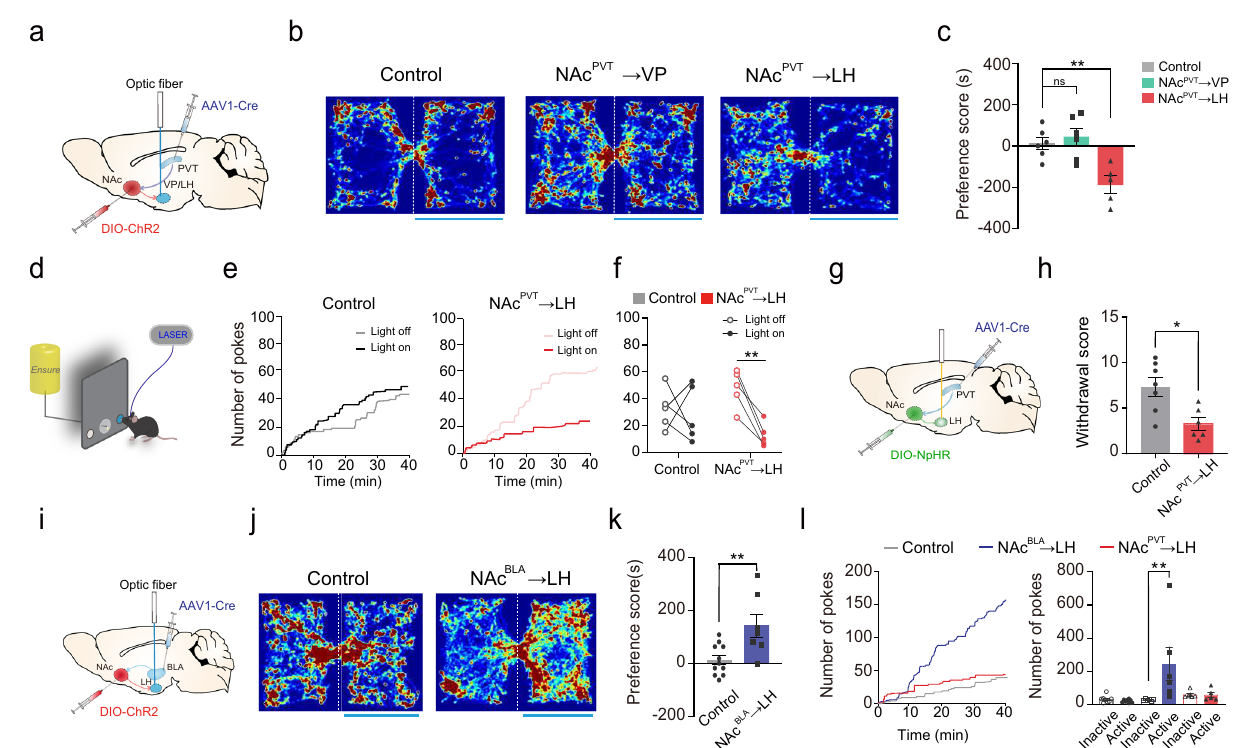
Fig. 6 | NAc PVT neurons mediate aversion by inhibiting GABAergic neurons in theLH. a Schematic showing viral strategy to activate NAc PVT axon terminalsinthe VP or the LH. b Example of heatmaps of activating NAc PVT → VP or NAc PVT → LH pathwayintheRTPPtest. c PreferencescoresforNAc::GFP( n =6),NAc PVT ::ChR2 → VP ( n =6) and NAc PVT ::ChR2 → LH ( n =5) groups in the RTPP test. One-way